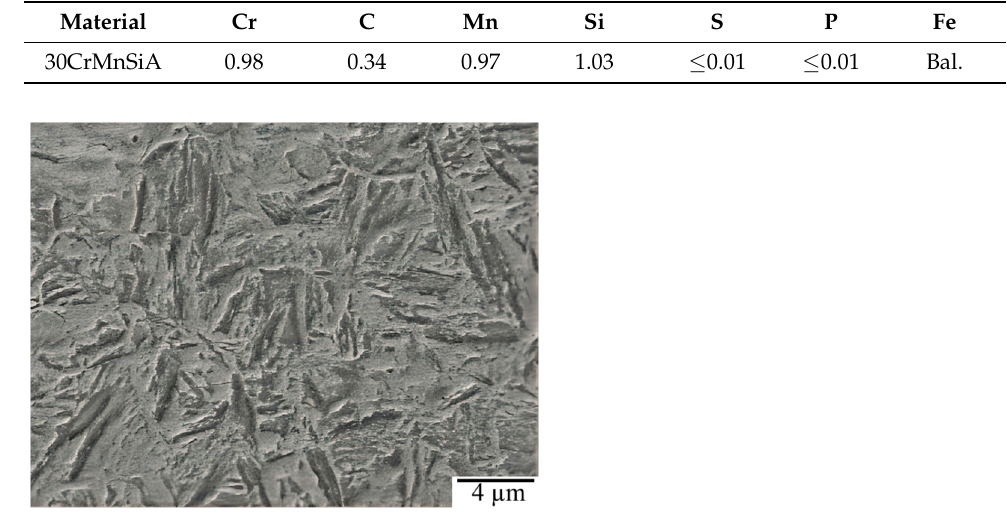
Figure 1. SEM microstructure of